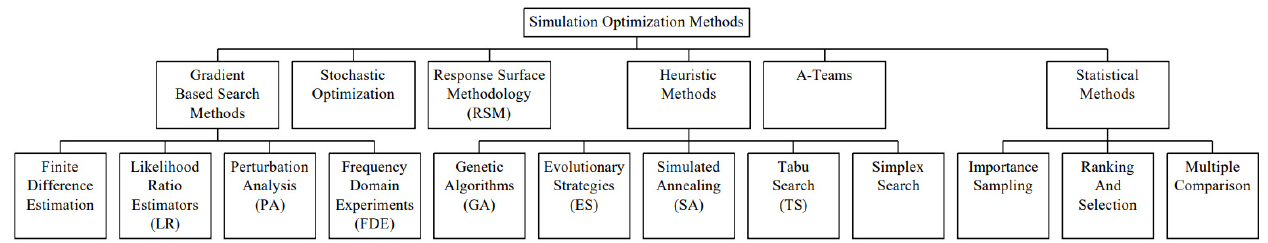
Figure 3. Taxonomy of Simulation Optimization Methods ([32], p. 119).